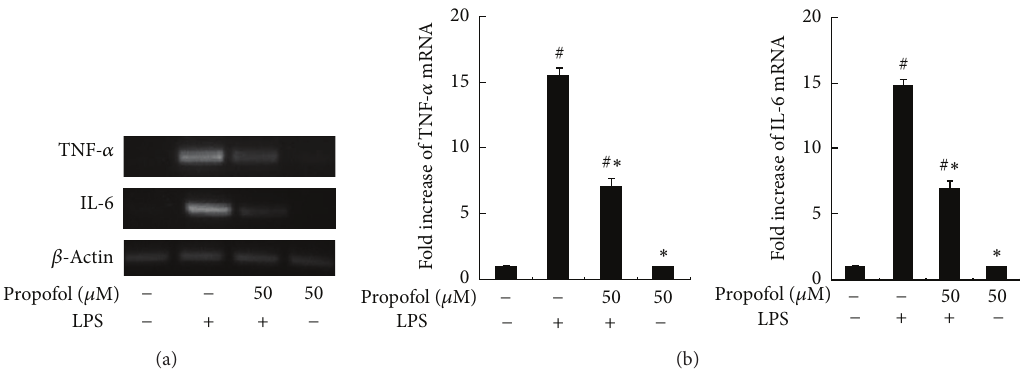
Figure2:EffectofpropofolonLPS-inducedTNF- 𝛼 andIL-6expression.(a)RAW264.7macrophageswerepretreatedwithdimethylsulfoxide (DMSO) or 50 𝜇 M propofol for 40min and then stimulated with LPS for 2h. Steady state mRNA levels of TNF- 𝛼 and IL-6 were examined by RT-PCR. (b) The levels of TNF- 𝛼 and IL-6 mRNA were quantified by measuring band intensities and shown as fold increase relative to 𝛽 -actin mRNA levels. Each value represents the means ± SD for 𝑛 = 4 . # and ∗ indicate statistically significant differences ( 𝑃 < 0.05 ) between propofol and LPS treated and LPS only treated groups,